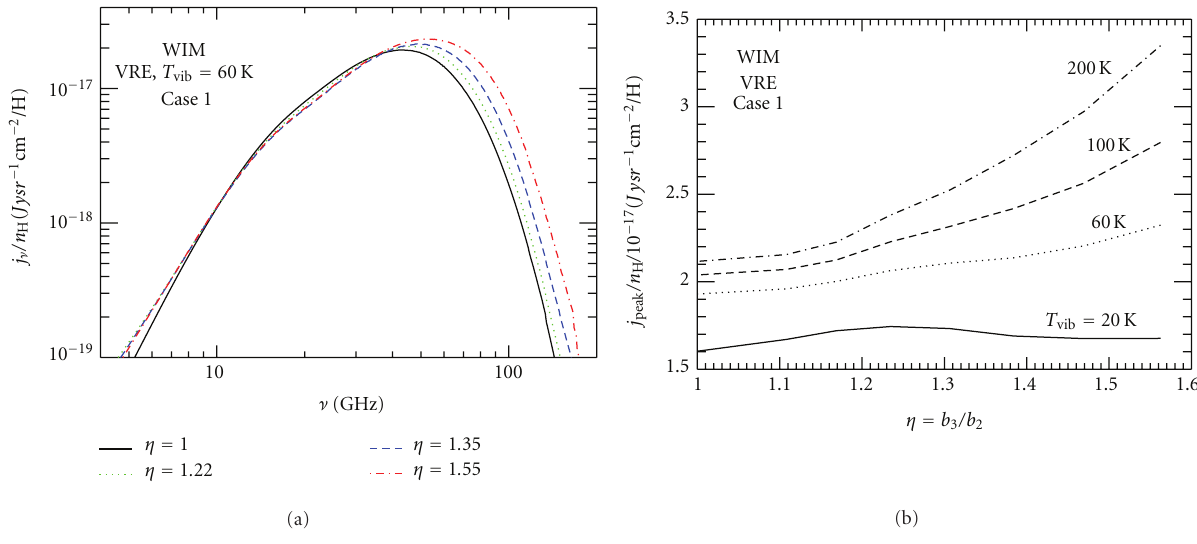
Figure 3: Emissivity per H from irregular grains of di ff erent degrees of irregularity η = b 3 /b 2 with T vib = 60 and 200K in the WIM for the case in which the electric dipole moment is isotropically oriented in the grain body (i.e., case 1 with μ 1 = μ/ shifts to higher frequency as η decreases (i.e., grain becomes more irregular). Here, the grain mass is held fixed as η changes. The figure is reproduced from Hoang et al.